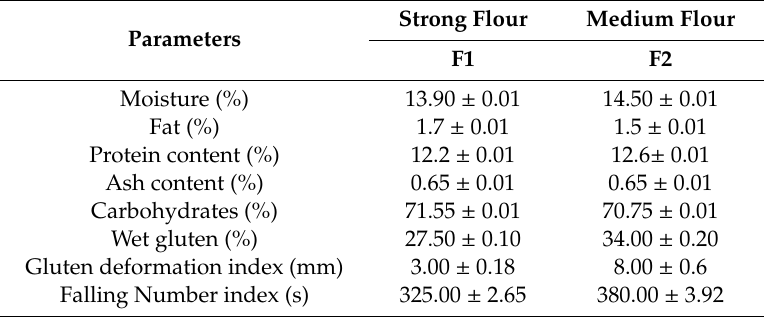
Table 1. Quality characteristics of wheat flour (mean value ± standard deviation).